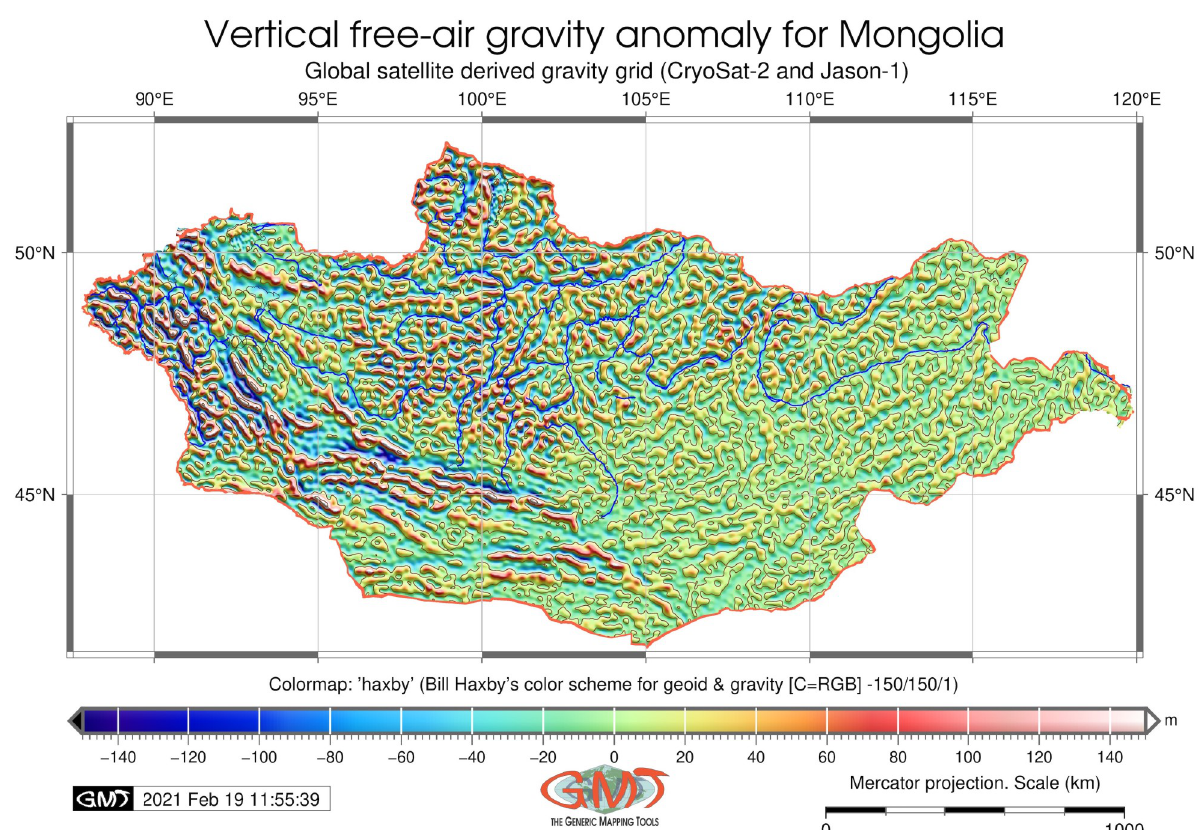
Fig. 5. Vertical free-air gravity anomaly of Mongolia. Mapping: GMT. Source: